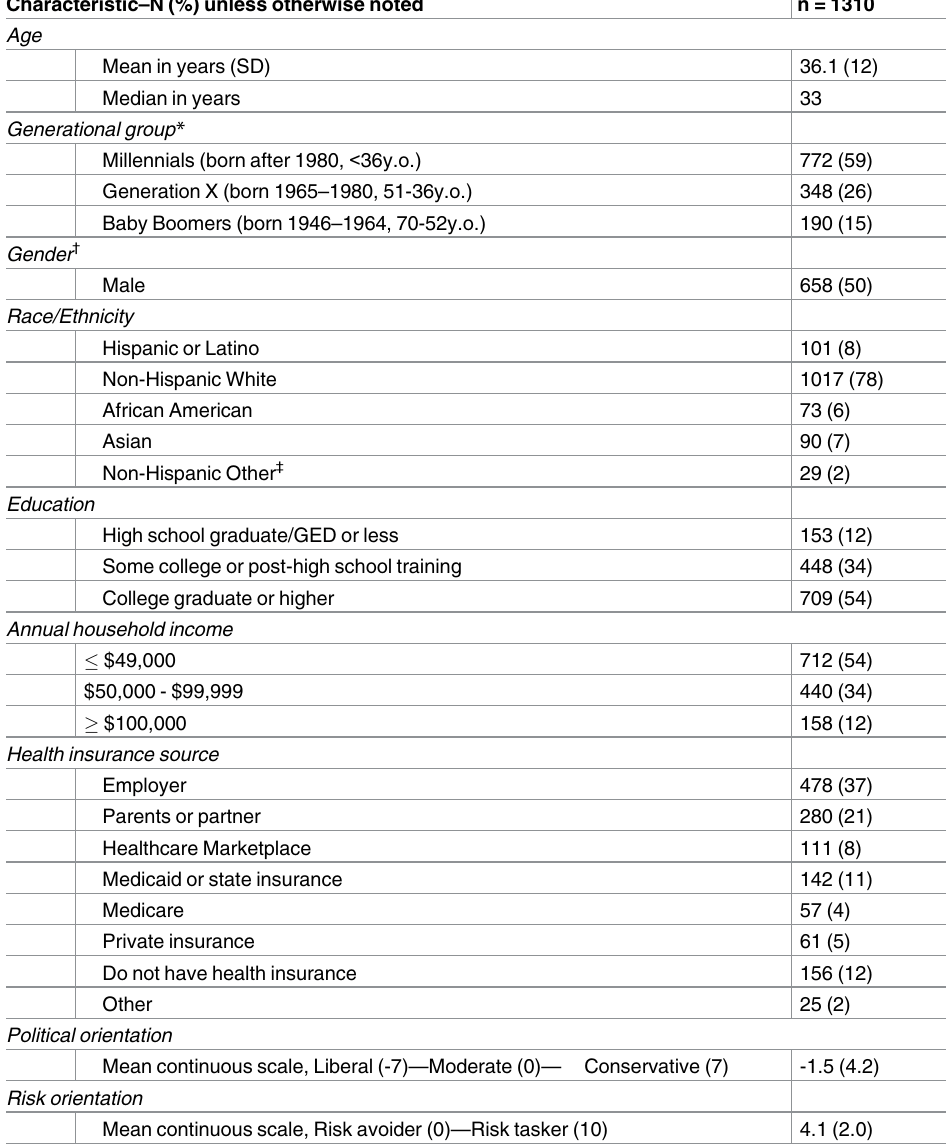
Table 1. Participant